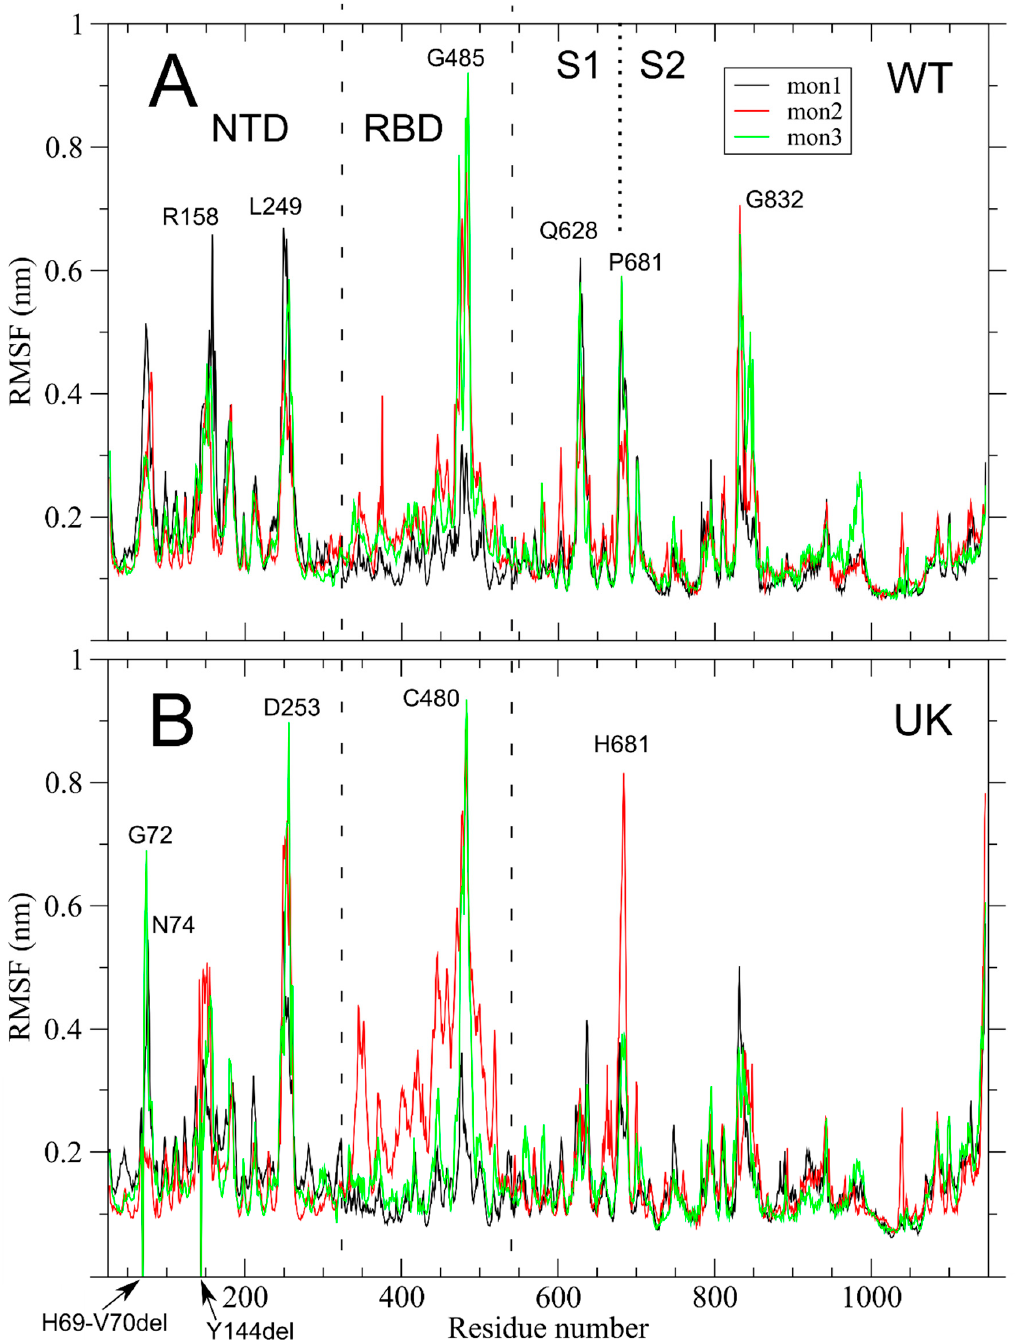
Figure 2. Per-residue RMSF in SARS-CoV-2 WT and UK systems are shown in panels ( A ) and ( B ), respectively. The three S monomers are colored in black, red, and green, respectively. Monomer 2 is in up conformation (see M&M). The NTD and RBD regions are highlighted with dashed lines. The S1/S2 boundary at residue 681 is highlighted with a dotted line. Residue numbers of fluctuation peaks are reported.